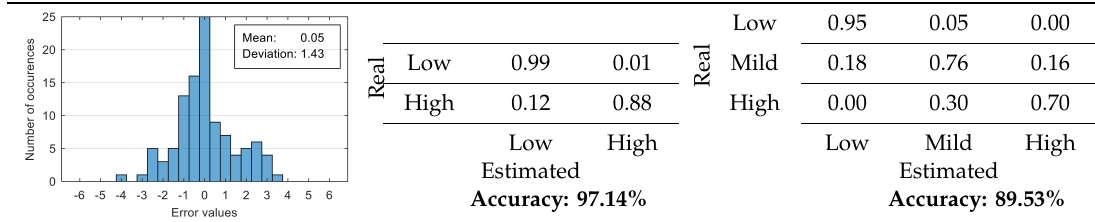
Table 9. Distribution of estimation errors and confusion matrices for levels 2 and 3 — using four features.